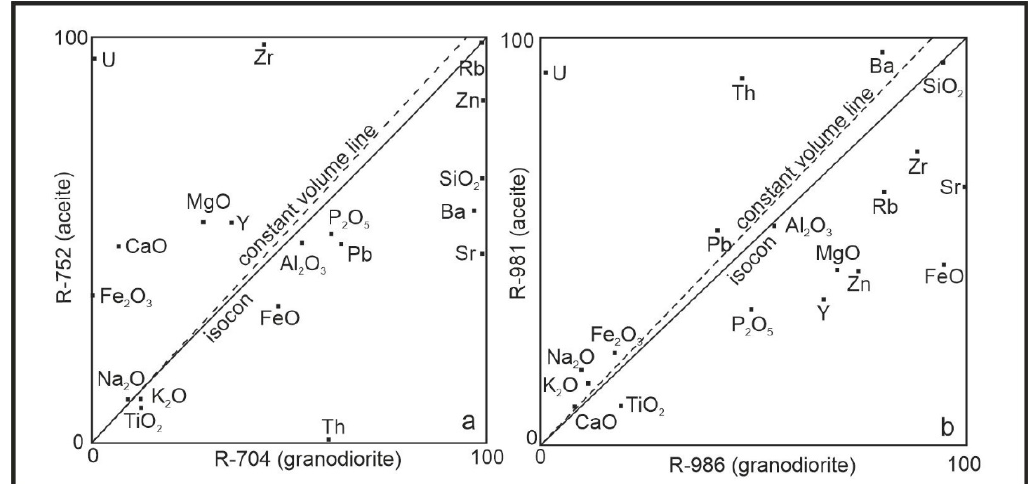
Figure 10. Isocon plot of the altered granodiorites (aceites) vs. unaltered granodiorites of the Blatná suite, ( a )—Nahošín uranium deposit; ( b )—Me č ichov uranium deposit.